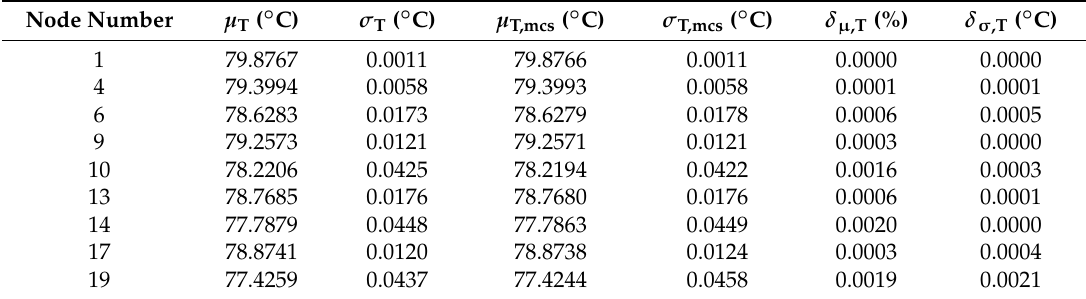
Table 4. Typical mean and standard deviations of node temperature. (Test 1: L = 1000 m; µ ϕ = 0.5 MW; σ ϕ = ± 10%).